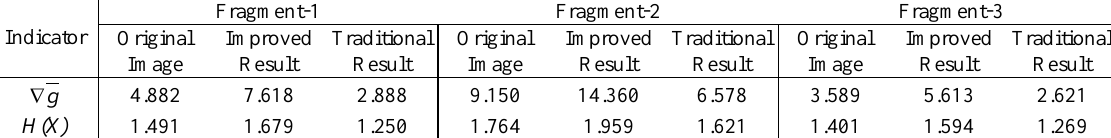
Table.2 Quantitative Parameters of Clear-sky